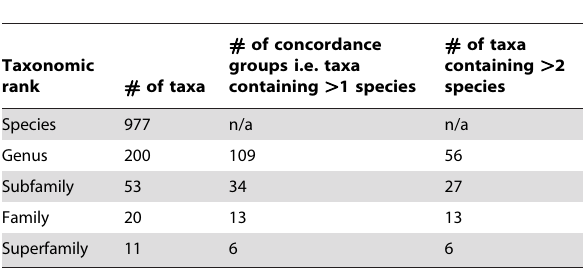
Table 3. The taxonomic structure of datamatrices used to measure phylogenetic utility and